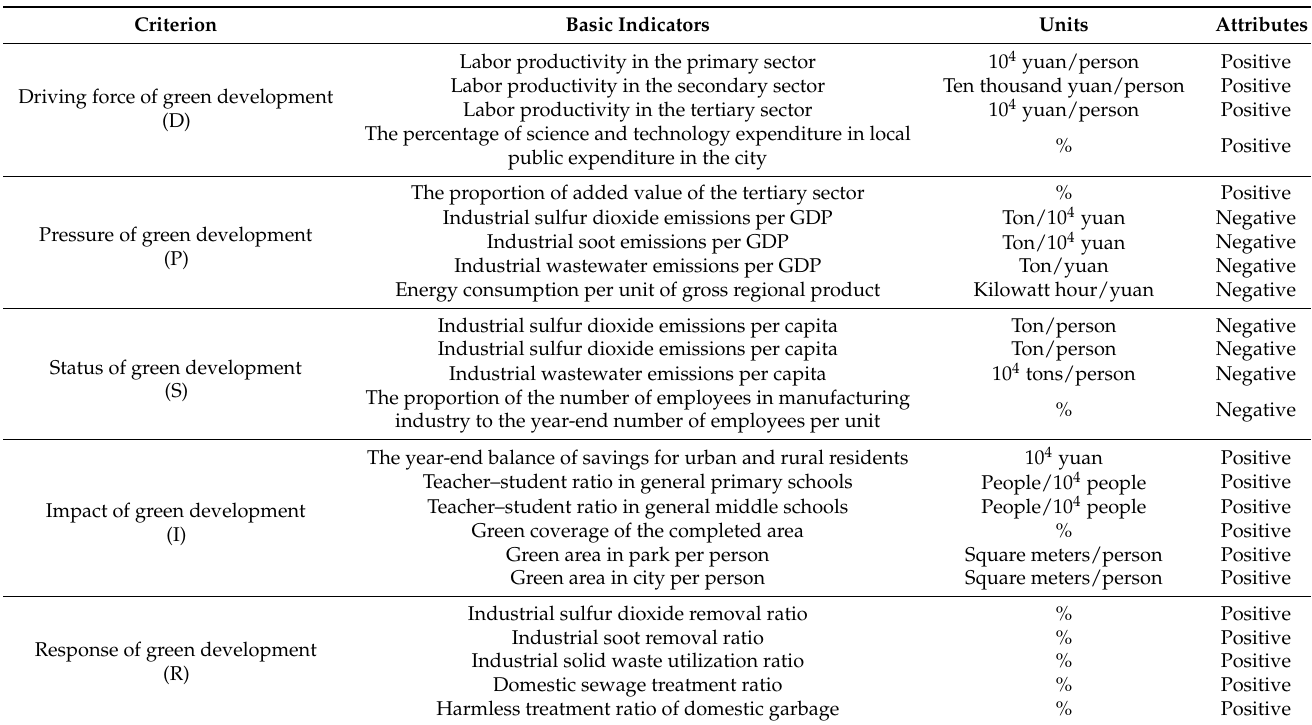
Table A1. DPSIR Indicator System of GD.